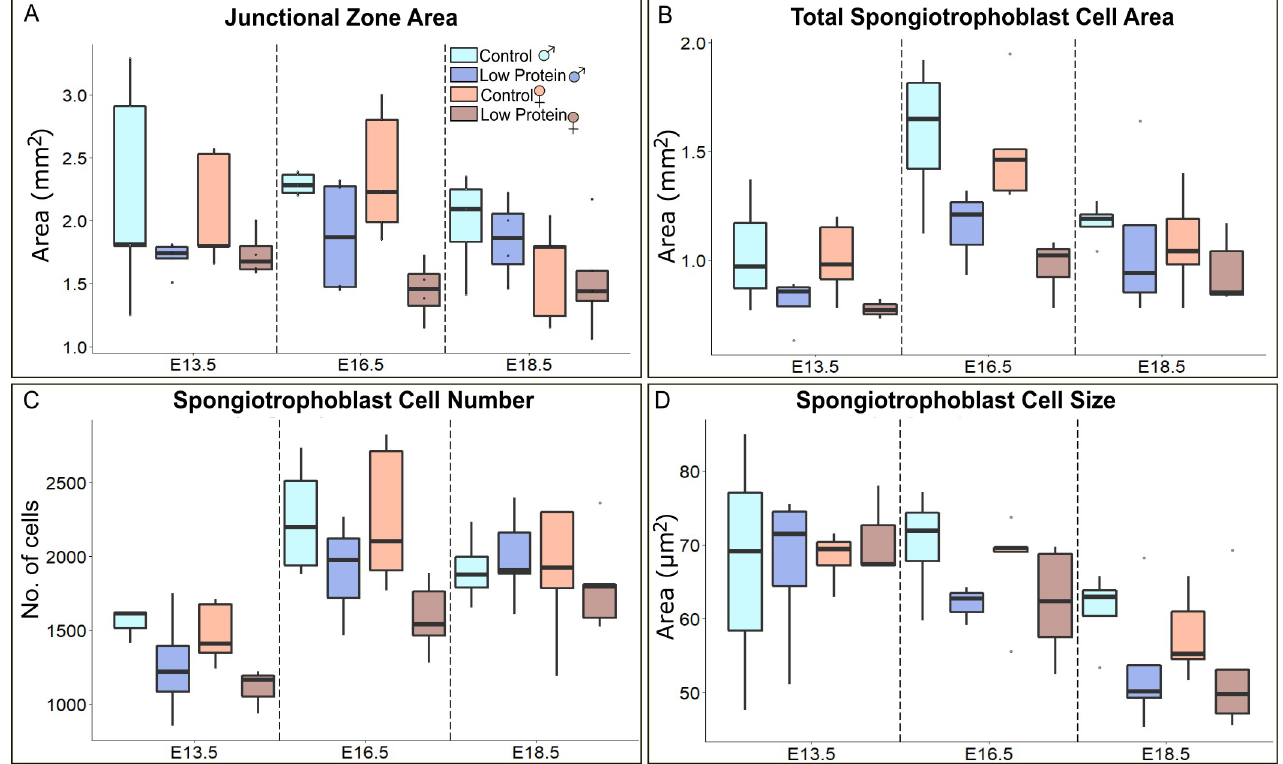
Fig 6. Spongiotrophoblast (SpT) cells contribute to the reduction in junctional zone size due to changes in cell size and number. (A) Junctional zone area. (B) Total SpT cell area was measured in Image J using automated thresholding, distinguishing SpT cells by expression of Prl8a8 mRNA. (C) Spongiotrophoblast cell number (n =